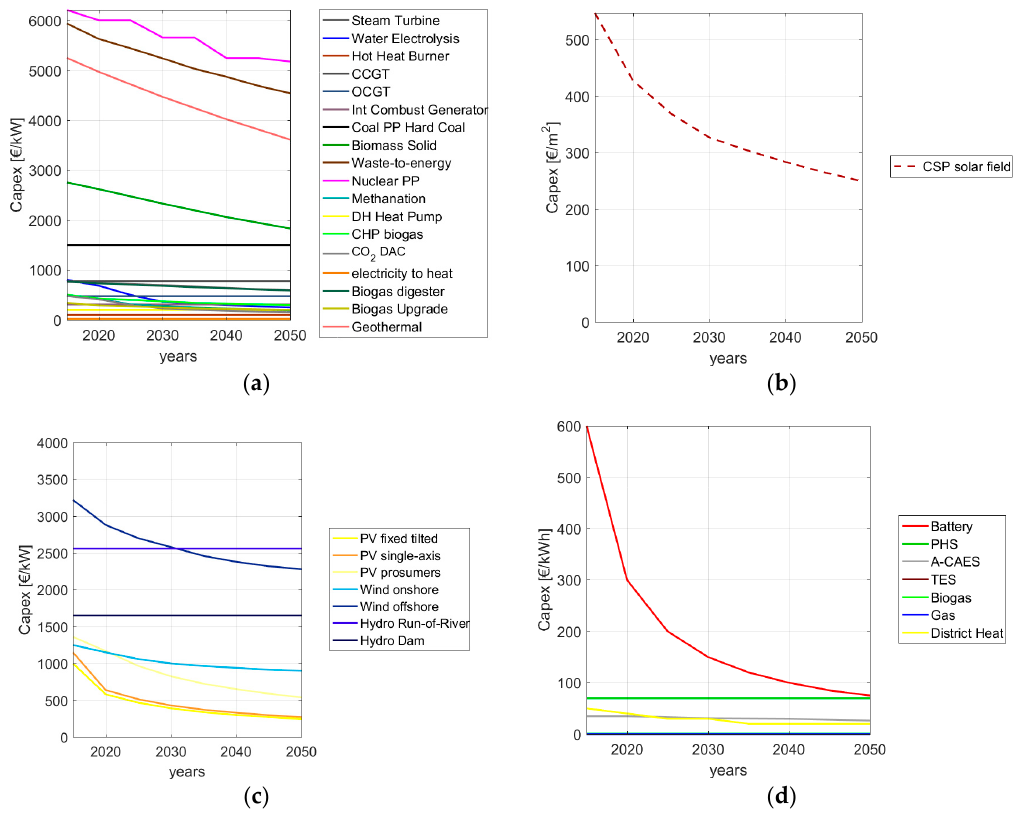
Figure 4. Variation in capex of power system components ( a ), CSP solar field ( b ), RE components ( c ) and storage components ( d ) assumed in the model.